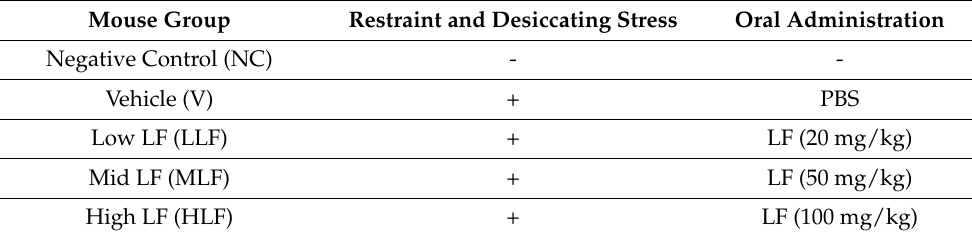
Table 1. Overview of the mouse groups in the phenol red thread test protocol. Mouse